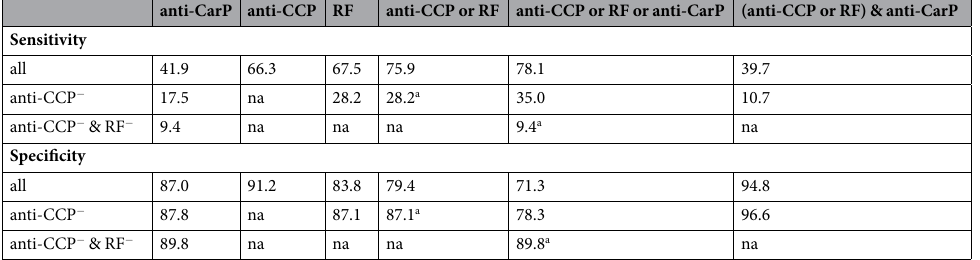
Table 2. Specificity and sensitivity for RA of the antibodies and their combinations. Antibodies were combined with either the or operator of the and (&) operator. All in the row headings refers to all RA patients, the other rows refer to the indicated subset of RA patients. a Values already presented in the table to the right, but duplicated to facilitate comparison. na = not